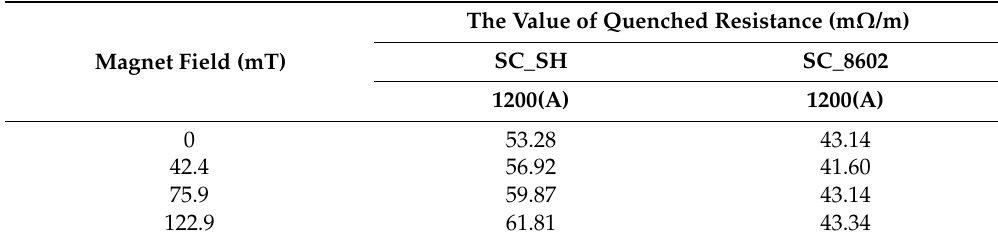
Table 3. Value of Quenched Resistance.